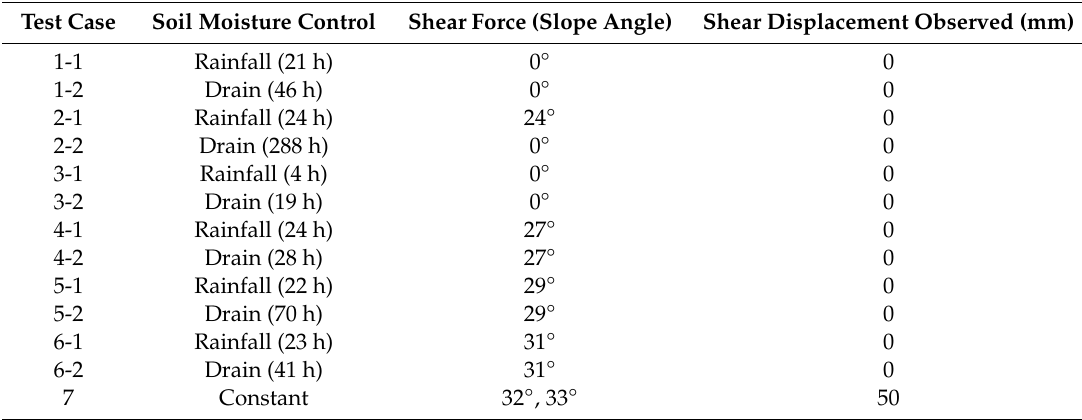
Table 1. Test cases and